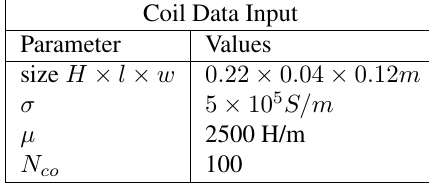
Table 1: FE numerical data for inductor geometric dimen- sion in a planar symmetry, and the magnetic parameters.